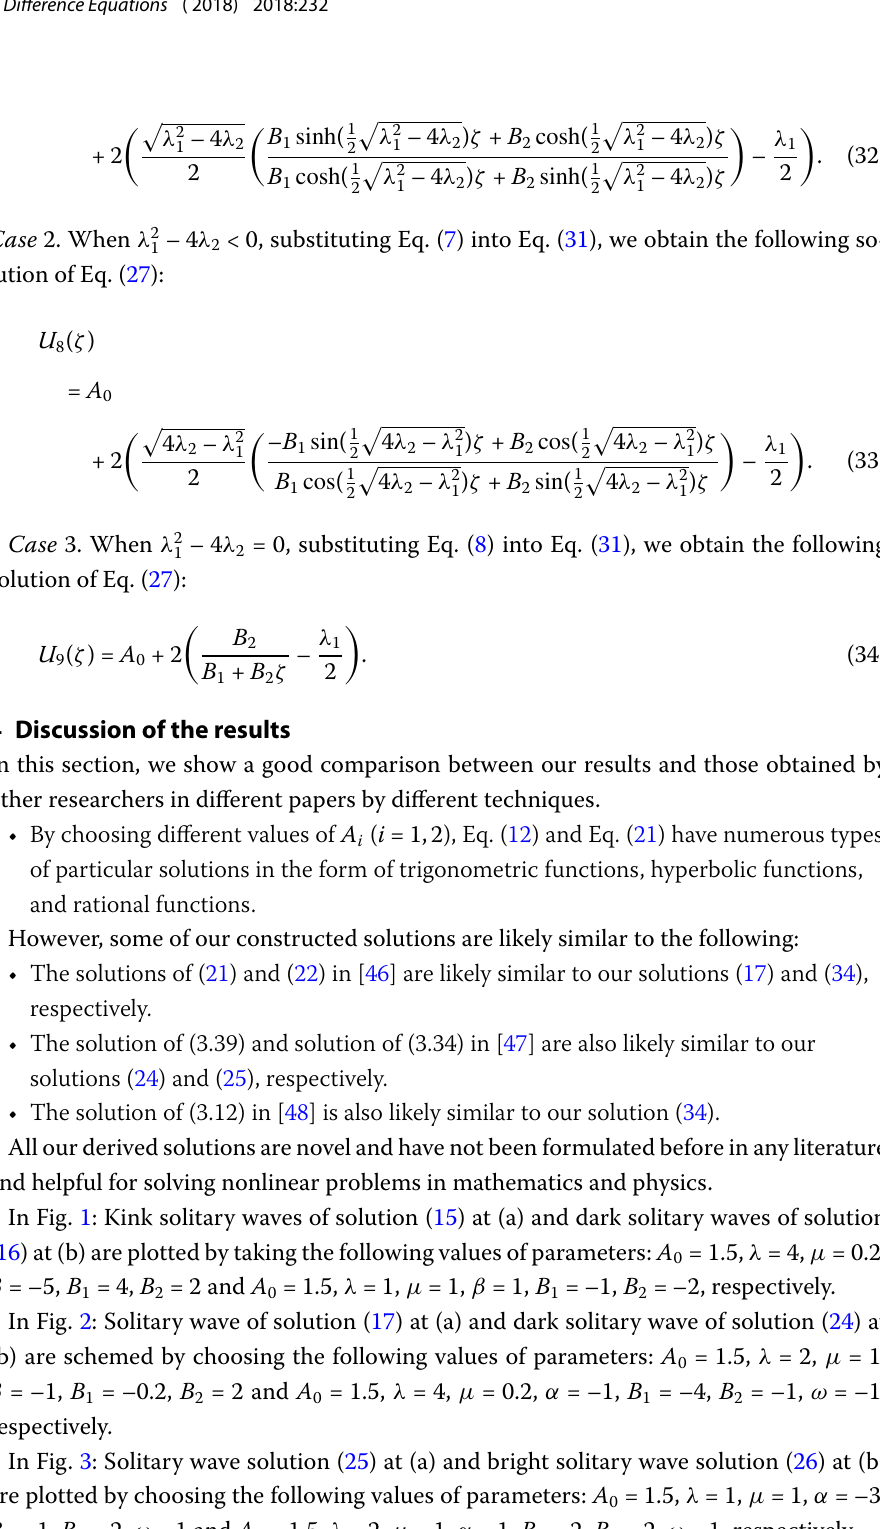
In Fig. 4: Kink solitary wave solution (32) at (a) and periodic solitary wave solution